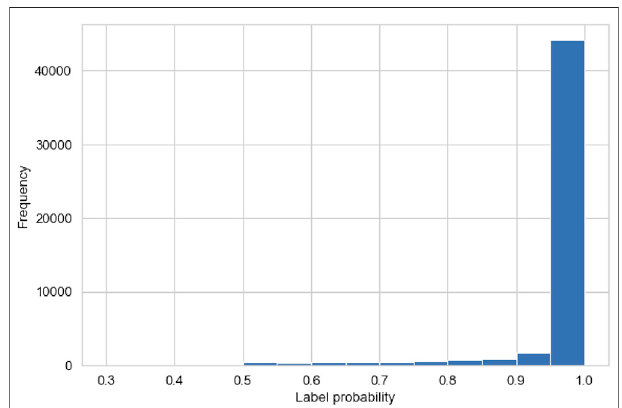
FIGURE 7 | Histogram showing the probabilities, generated by Gaussian mixture model (GMMs), that the data-points belong to the cluster assigned to them by the agglomerative clustering algorithm.